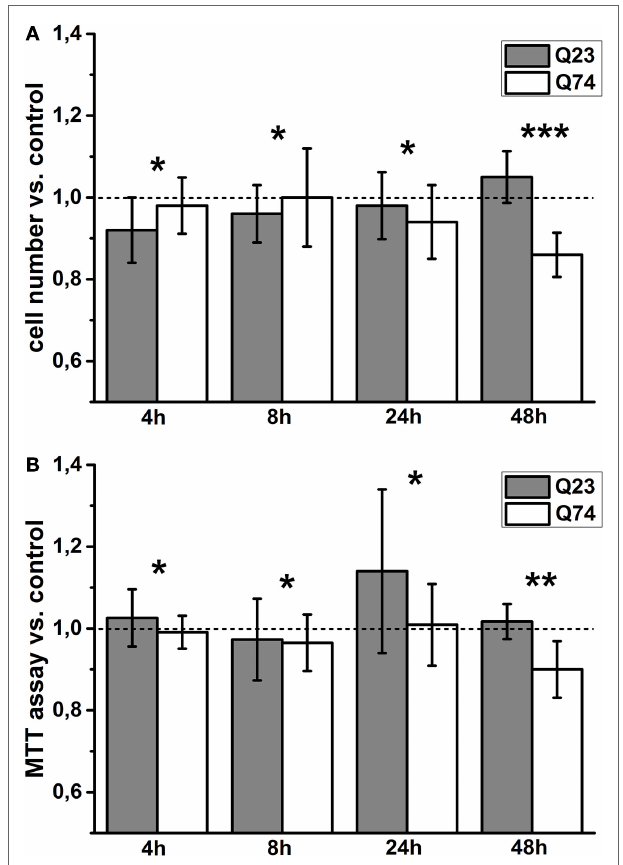
FigUre 1 | Viability changes of Pc12 hD-Q23 and Pc12 hD-Q74 cells with expression of htt and mhtt, respectively, induced for a given period of time . Cells were cultured in 24-well plates, and the expression of Htt and mHtt was performed for a given period of time. The change index for (a) cell number adhering to the bottom of the plates and (B) the MTT cell proliferation colorimetric assay. The change index was calculated between cells expressing Htt or mHtt and control cells, i.e., cultured for the same time but without Htt or mHtt expression. The data are presented as mean values ± SD of three independent experiments. Statistical analysis was based on t -test: * – not statistically significant, ** – not quite statistically significant ( p = 0.067), *** – statistically significant ( p <